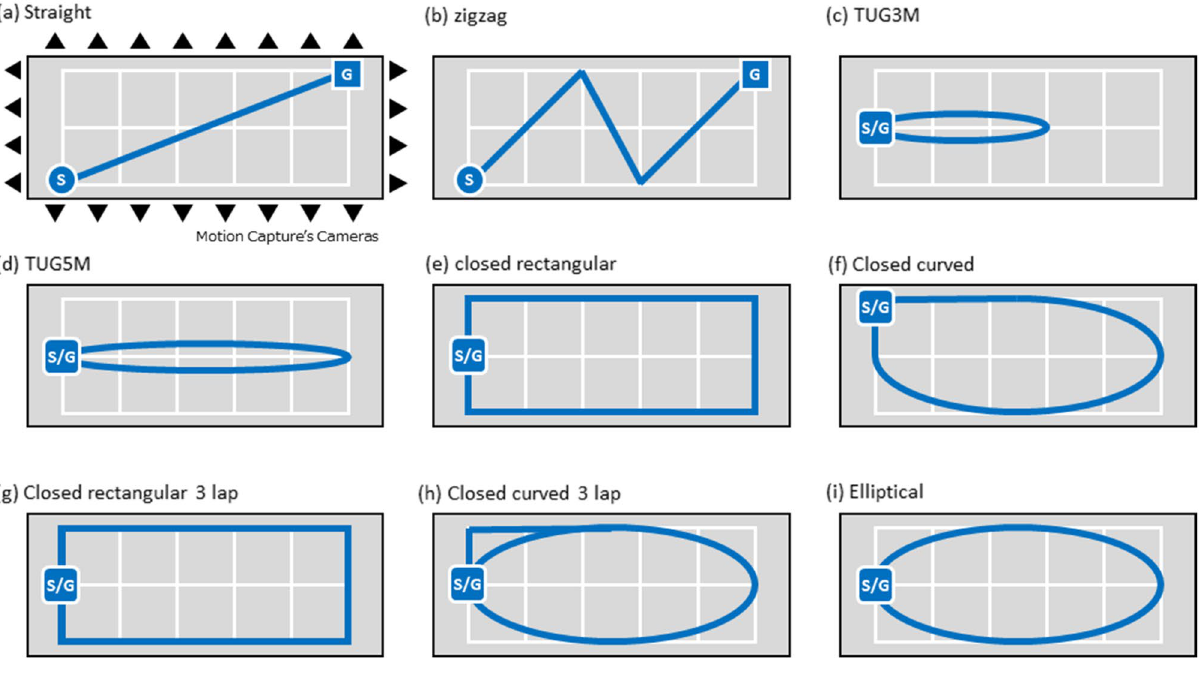
Figure 13. Nine walking route experimental conditions: ( a ) straight, ( b ) zigzag, ( c ) TUG3M, ( d ) TUG5M, ( e ) closed rectangular, ( f ) closed curved, ( g ) closed rectangular 3 lap, ( h ) closed curved 3 lap, and ( i )